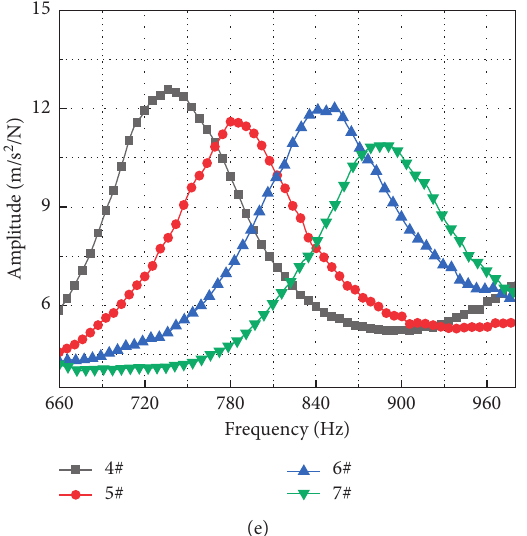
Figure 8: First five transfer function curves of cantilever beams 4# ∼ 7# (experimental temperature: 23.5 ° C). (a) Mode 1. (b) Mode 2. (c) Mode 3. (d) Mode 4. (e) Mode 5.